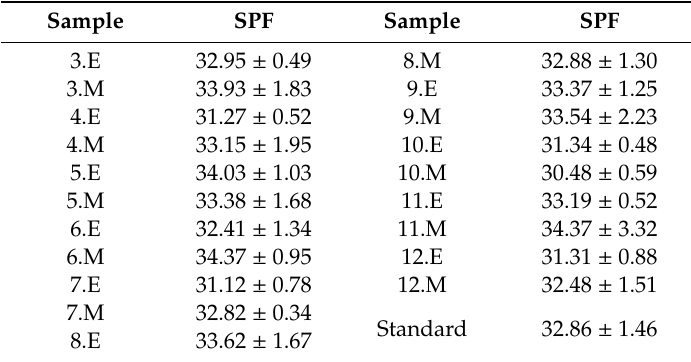
Table 4. UV protection of samples at a concentration of 250 µ g /